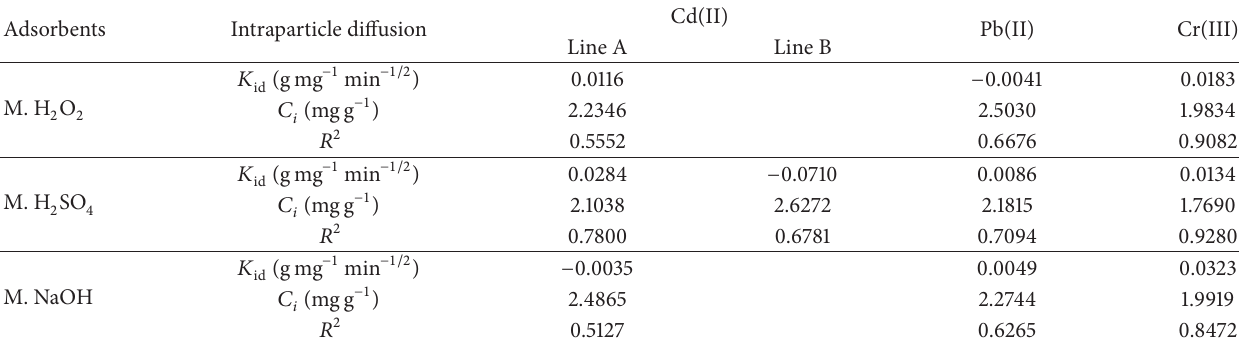
Table 7: Kinetic parameters inherent to the intraparticle diffusion model for the removal of the metals Cd(II), Pb(II), and Cr(III) by adsorbents M. H 2 O 2 , M. H 2 SO 4 , and NaOH.